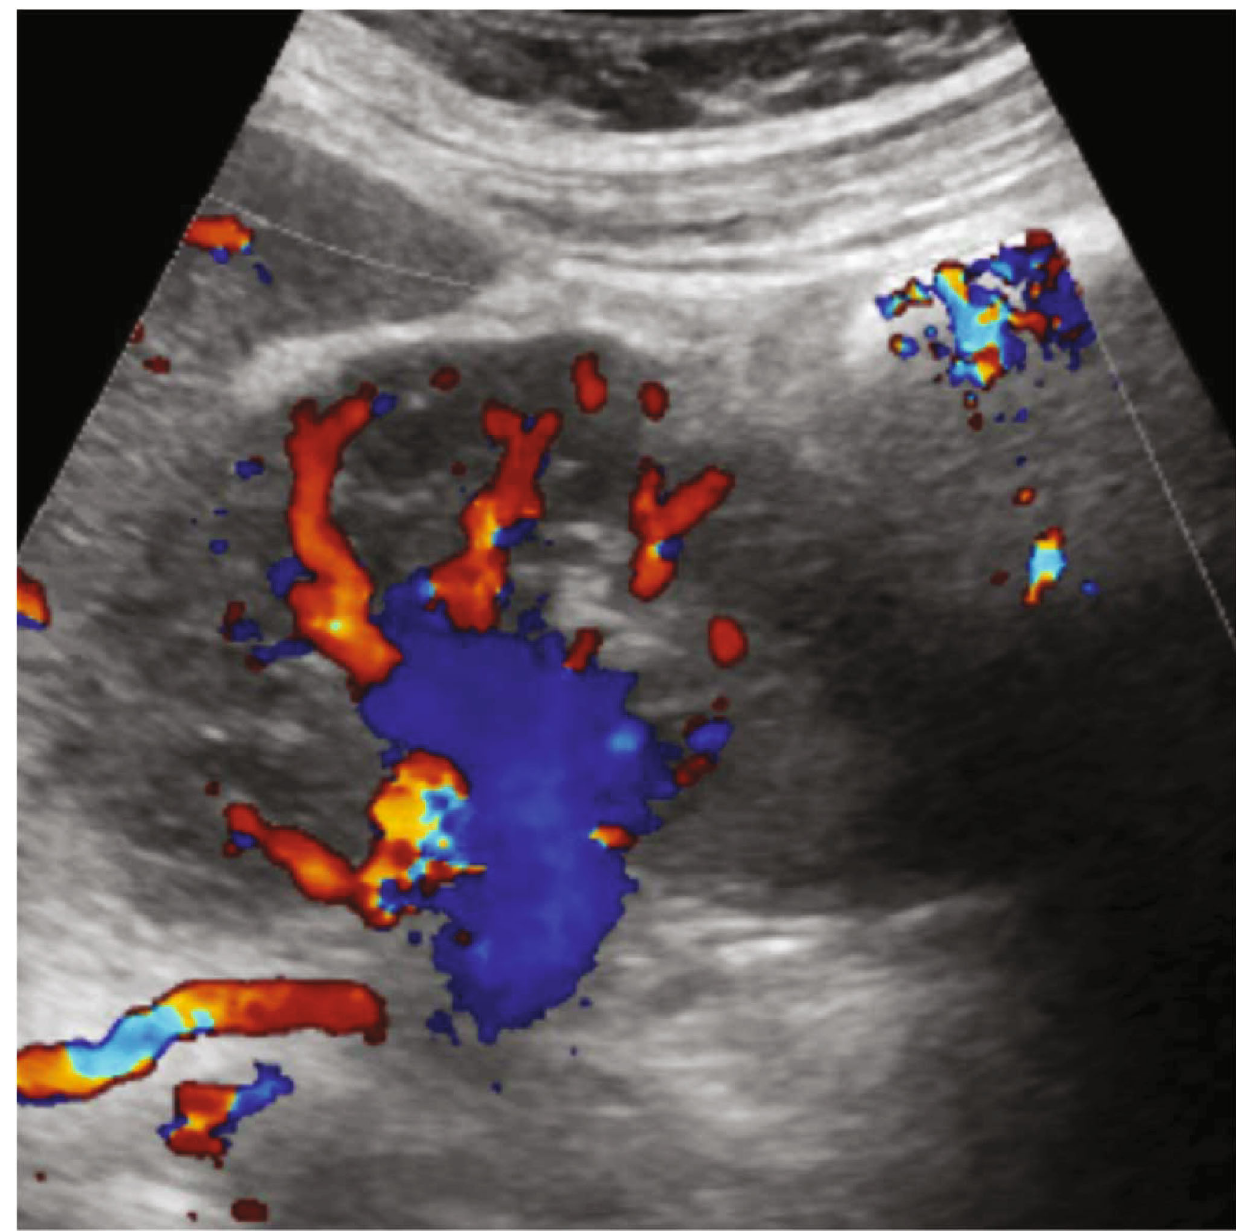
Figure 14: US color Doppler shows patent color fl ow in distal